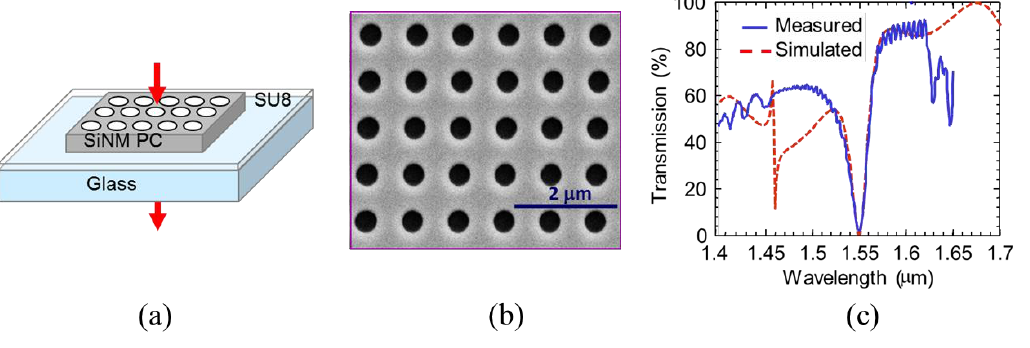
Figure 5. A SiNM PCS Fano filter realized by the “wet” flip transfer printing method. ( a ) Transferred SiNM PC membrane filter on a glass substrate; ( b ) SEM zoom-in view; ( c ) Measured and simulated transmission. Reproduced by permission of the Institution of Engineering and Technology